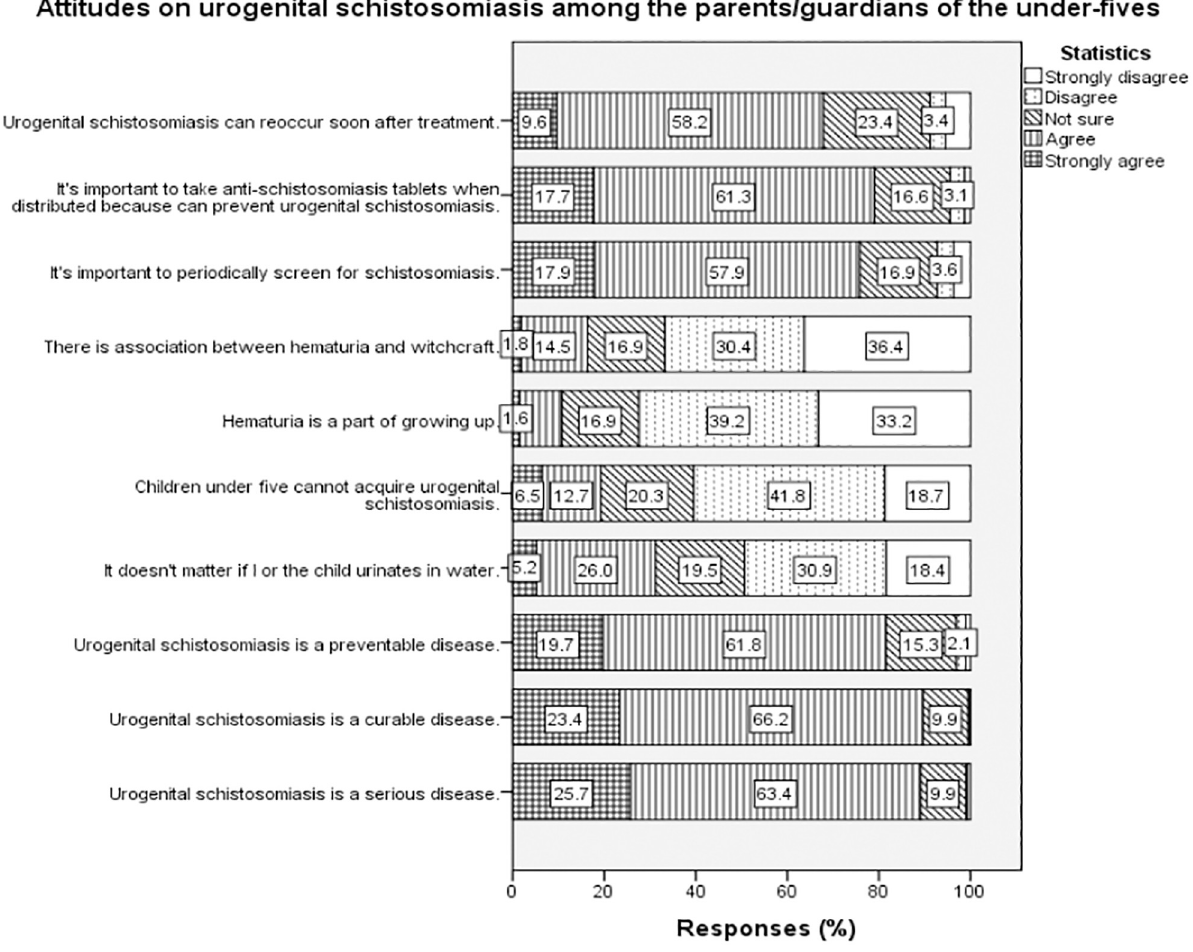
Fig 2. Attitudes on urogenital schistosomiasis among the parents/guardians of the under-fives.